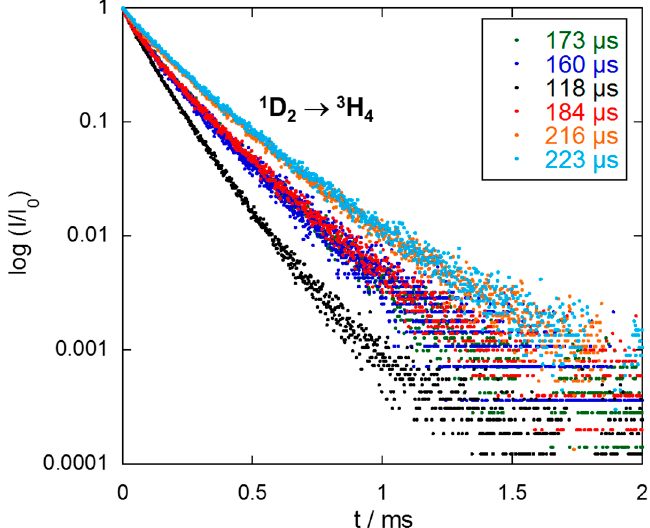
Figure 12. Luminescence decay curves of the Pr 3 + 1 D 2 → 3 H 4 emission of Y 2 O 3 : Pr 3 + NCs prepared by: combustion method after calcination at 900 ◦ C for 4 h (green); molten salt procedure at 500 ◦ C followed by 10 washing cycles (blue); sol–gel Pechini using citric acid as chelating agent and followed by calcination at 900 ◦ C for 16 h (black); homogeneous precipitation using 0.832 mol of urea and 200 mL of H 2 O during 2 h reaction followed by thermal treatment at 800 ◦ C for 3 h (red); solvothermal method at 220 ◦ C followed by calcination at 1000 ◦ C for 4 h (orange); and solvothermal method at 220 ◦ C followed by calcination at 900 ◦ C for 4 h (cyan).